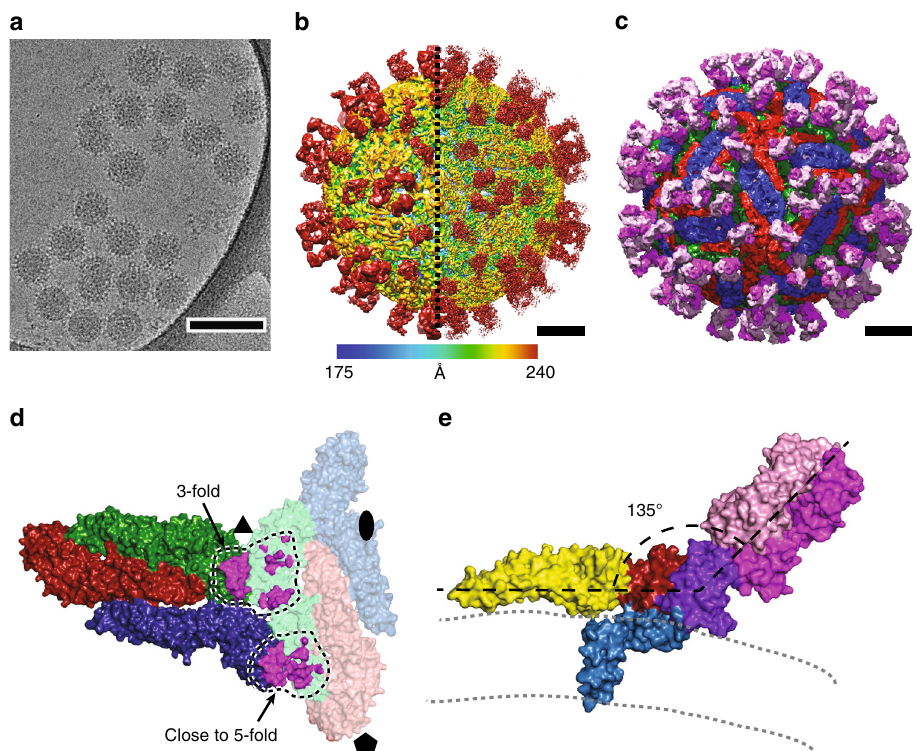
Fig. 4 Interaction of TBEV virions with Fab fragments of neutralizing antibody 19/1786. a Cryo-EM micrograph of TBEV virions incubated with Fab fragments of 19/1786. Scale bar represents 100 nm. b Electron-density map of Fab-covered TBEV virion rainbow-colored according to distance from center of particle. The right half of the image represents a B-factor sharpened map. Electron densities corresponding to the Fab fragments are located close to the 3-fold and 5-fold symmetry axes of the virion. c Molecular surface of TBEV virion covered with Fab 19/1786 fragments low-pass fi ltered to 7 Å resolution. E-proteins are shown in red, green, and blue. Fab fragments are shown in magenta (heavy chain) and pink (light chain). Scale bars in b and c represent 10 nm. d Footprints of Fab 19/1786 on TBEV surface. Fab fragments bind to two of the E-proteins of the asymmetric unit. The Fabs interact with an additional E-protein from the neighboring asymmetric unit shown in faint colors. e The Fab 19/1786 binds to the domain III at an angle of 135° relative to the axis of the E-protein ectodomain. The E-protein domain I is shown in red, domain II in yellow, domain III in violet, and domain IV in blue. The heavy chain of the Fab fragment is shown in magenta and the light chain in pink. The lea fl ets of the viral membrane are represented by gray dashed